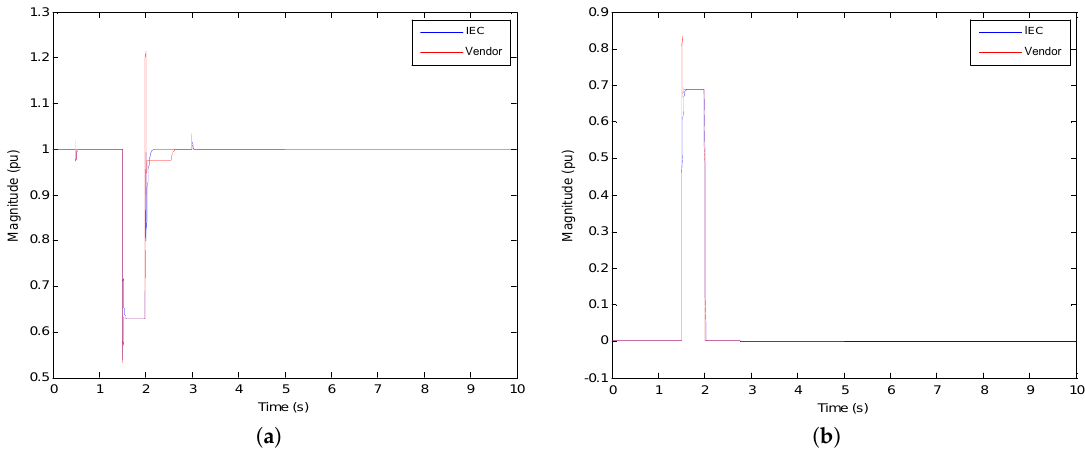
Figure 14. Type IVA results. Simulation scenario: p = 1.0 pu, u = 0.50 pu, t = 500 ms. ( a ) Active power, p ; and ( b ) reactive current, i q